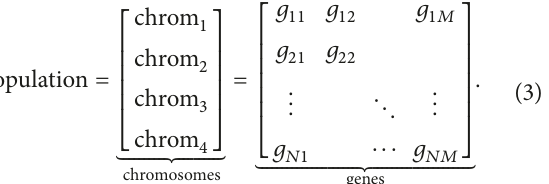
Figure 2: Fields components of